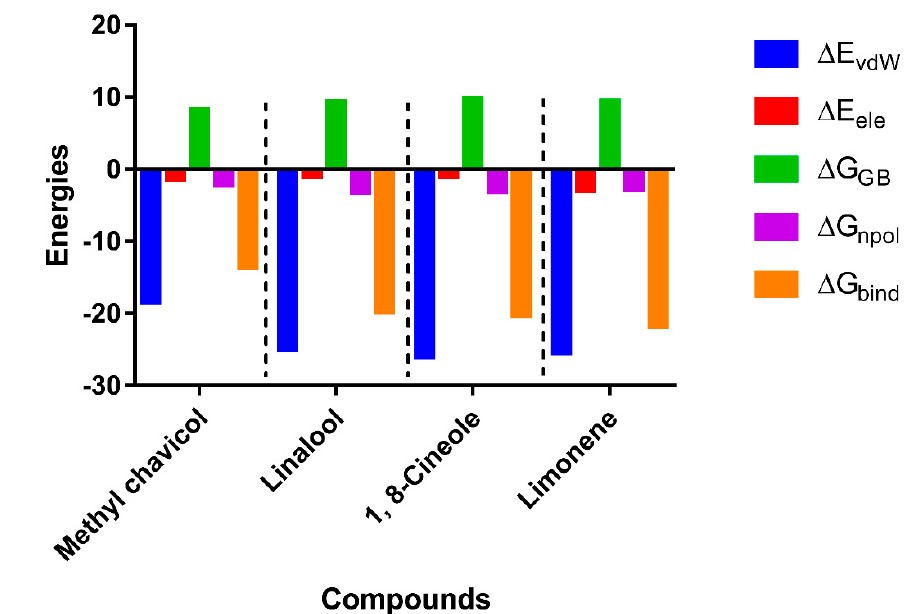
Figure 5. Binding energy values and energy components. ∆ E vdW , contributions by van der Waals interactions; ∆ E ele , electrostatic energy; ∆ G GB , polar solvation energy; ∆ G npol , nonpolar solvation energy; ∆ G bind , binding affinity.